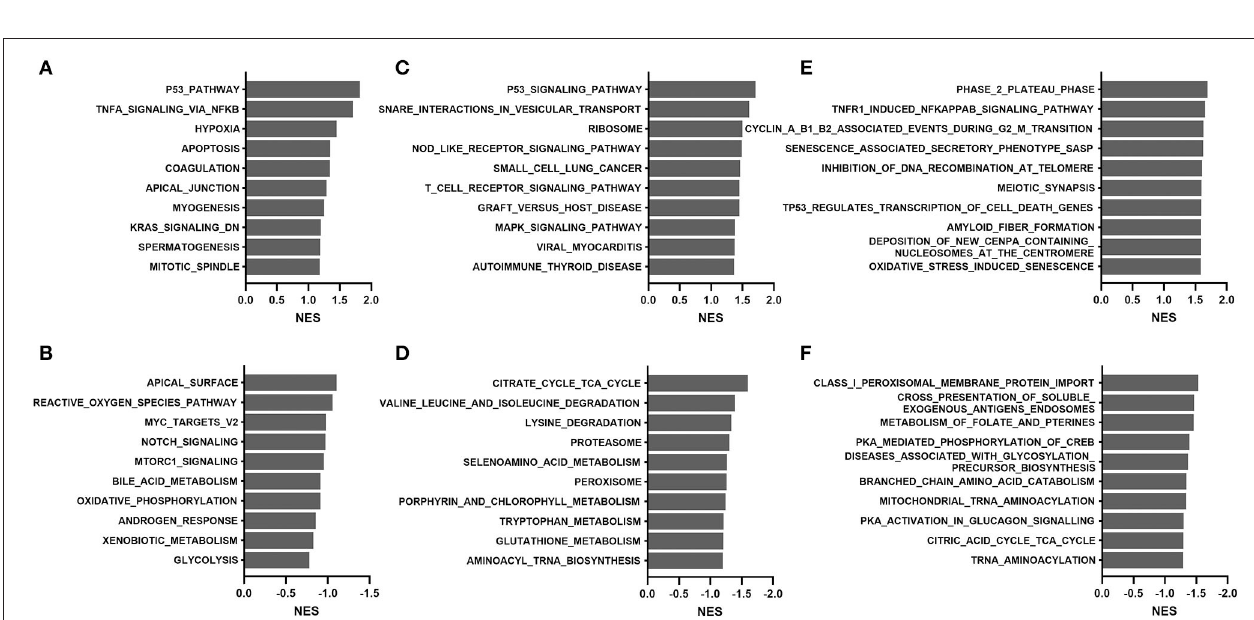
FIGURE 5 | Over-representation pathway analysis of three top-ranked WGCNA modules in the TCGA THCA dataset: PANTHER protein class, KEGG, Reactome, and BioCarta. The top three classes or pathways are listed. Values above the dashed line represent significant enrichment (5% level of significance). FDR, false discovery